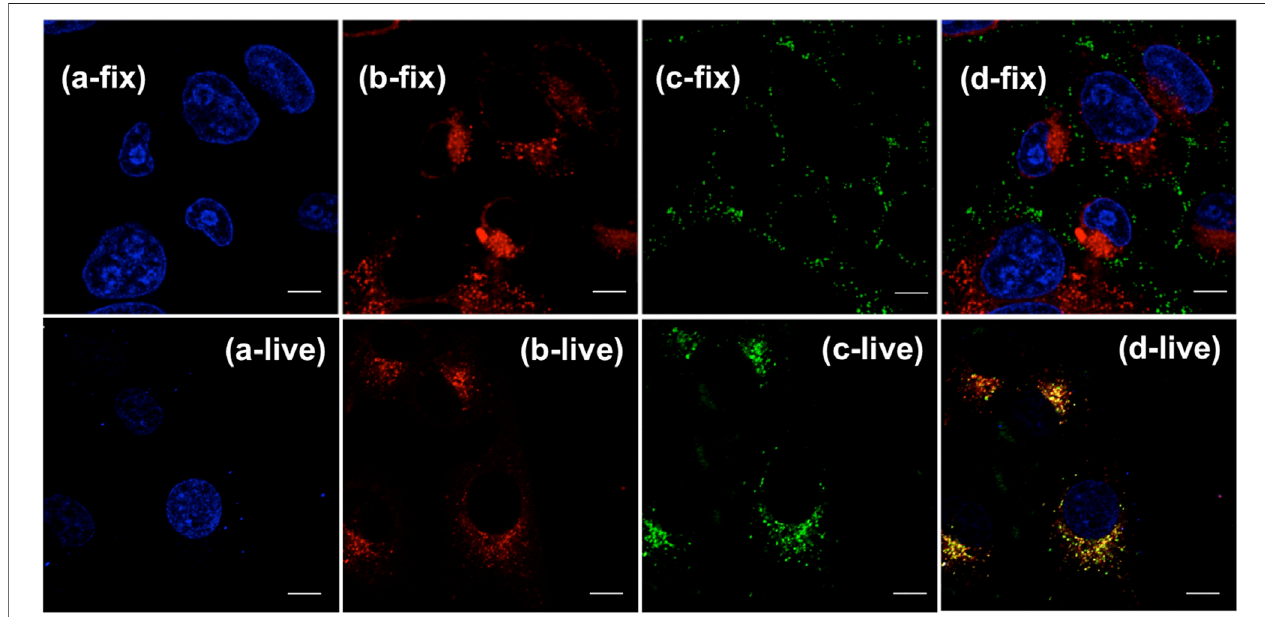
FIGURE 5 | CLSM images of live Hela cell (a-/b-/c-/d-live) and DMF fi xed cell (a-/b-/c-/d- fi x) co-stained with commercial dyes and probe: (A) channels of nuclear stain Hoechst 33,342; (B) channels of mitochondria tracker MitoTracker ® Red; (C) channels of fi xed and live cells stained with (OMeTPA)2-Pyr (1.5 μ g/ml) in 24 h, respectively; (D) Merged image of all channels. Scale bar, 10 μ m.